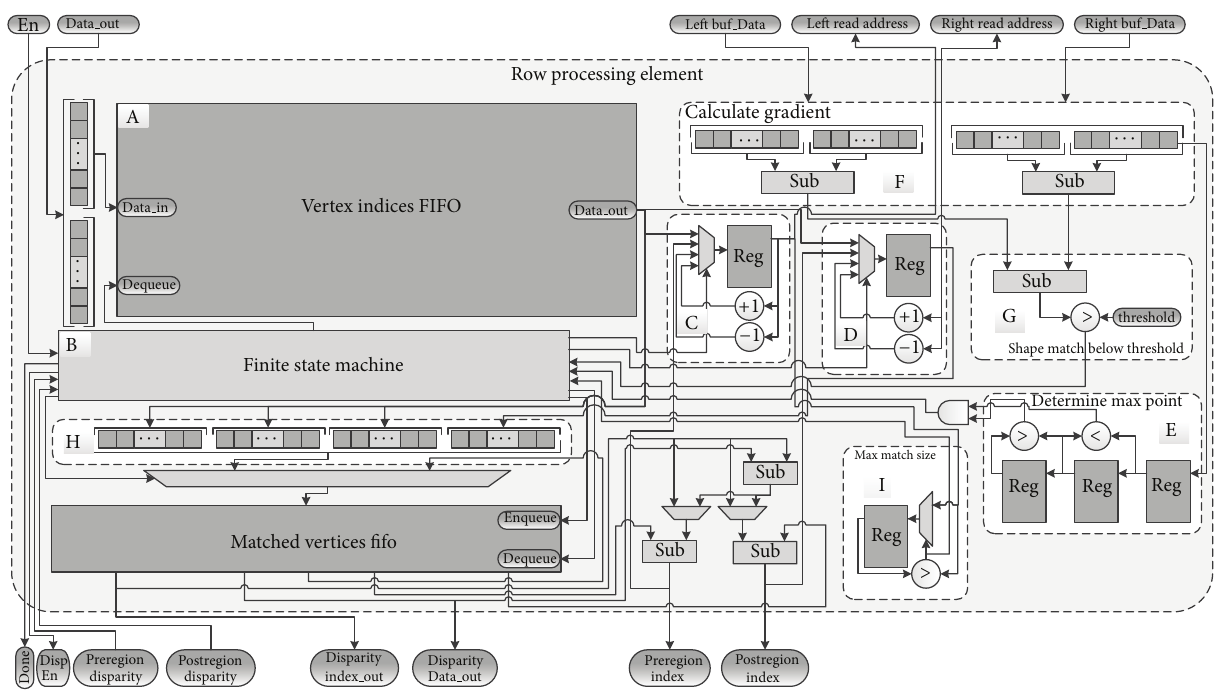
Figure 5: Row processing element (RPE) hardware block diagram.